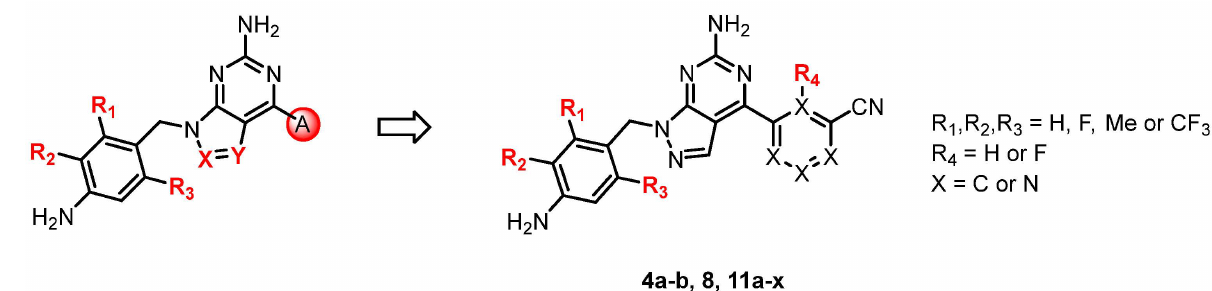
Figure 2. Design of the core